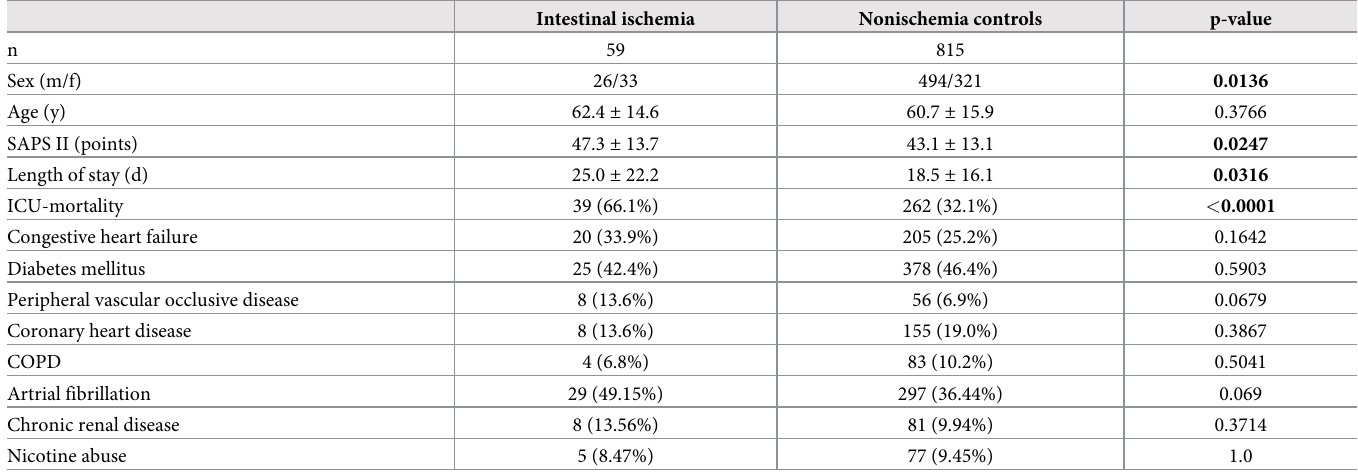
Table 1. Patients baseline